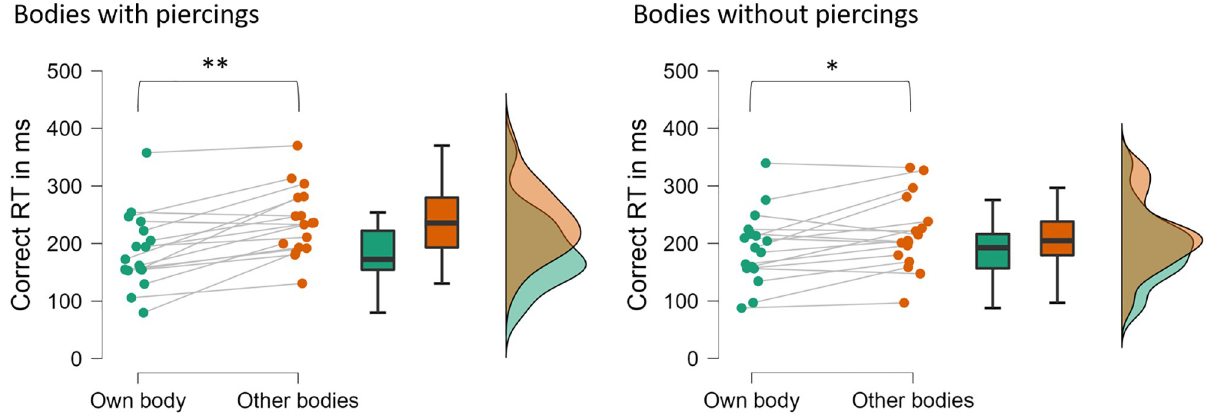
Fig 6. Raincloud plots of correct RTs to own (turquoise) and strangers’ bodies (orange) with (left panel) and without (right panel) navel piercings. Each circle represents one participant, � denotes p < .05, �� denotes p < .001.